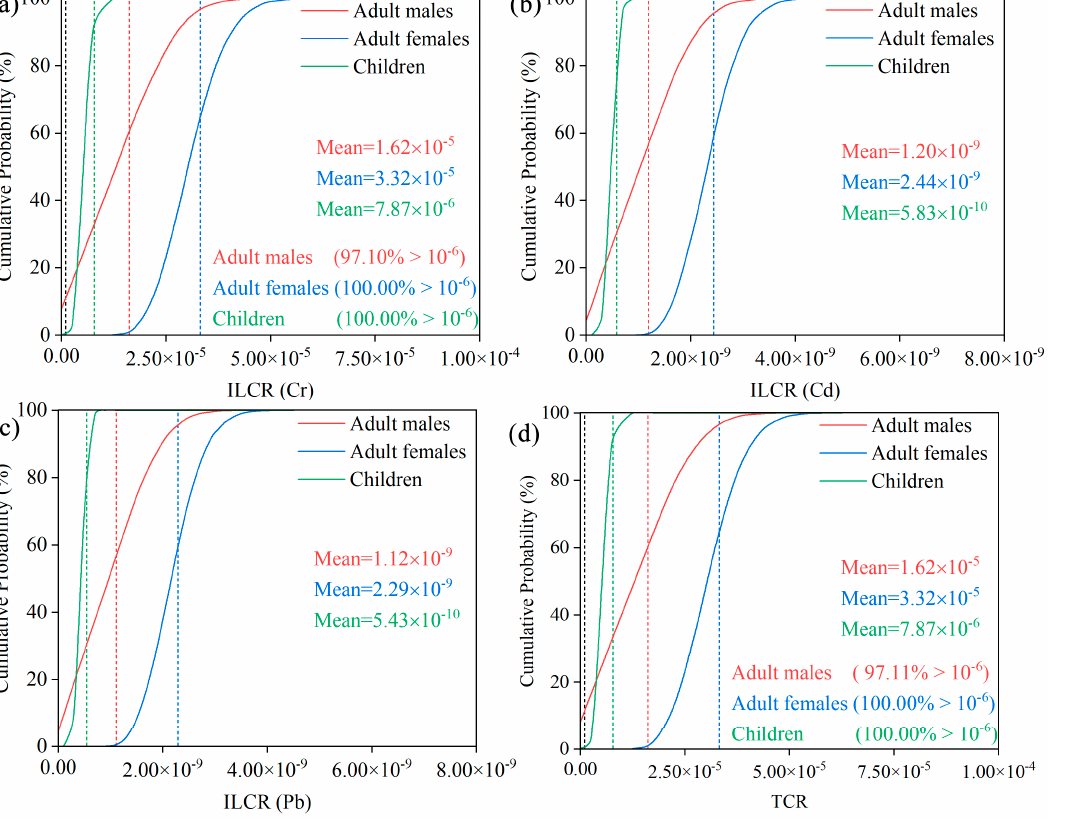
Figure 5. Probability distribution and the percentage of incremental lifetime cancer risk (ILCR) values surpassing 1.00 × 10 − 6 for ( a ) Cr, ( b ) Cd, ( c ) Pb, and ( d ) to the total cancer risk (TCR). (The red, blue, or green dashed vertical lines represent the mean values, whereas the black is the acceptable carcinogenic risk value of 1.00 × 10 − 6 .).